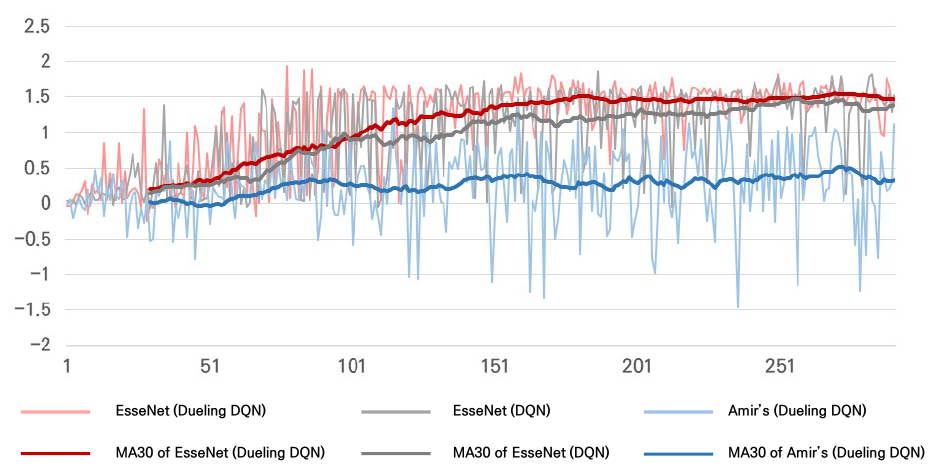
Figure 5. The average reward per episode during training: The average reward values per episode and their moving averages with a window size of 30 for the three methods, EsseNet with dueling- DQN (light red/dark red), EsseNet with plain DQN (light gray/dark gray), and Amir et al. [2] (light blue/dark blue) are presented,